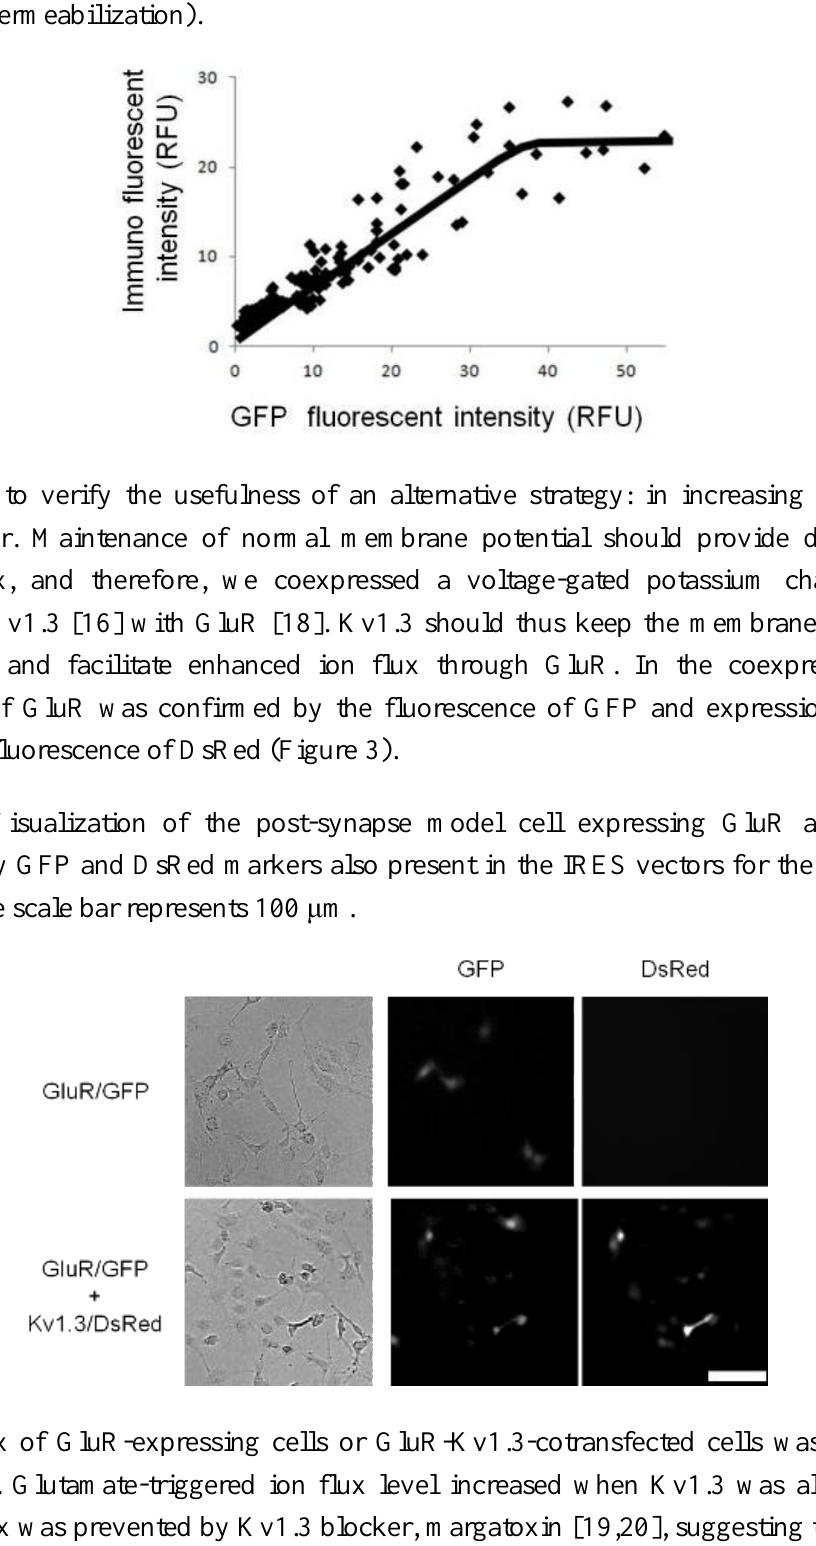
Figure 2. Relationship between fluorescent intensity of GFP (coexpressed with GluR) and immunofluorescence staining of GluR on cell surface (without cellular membrane-permeabilization).